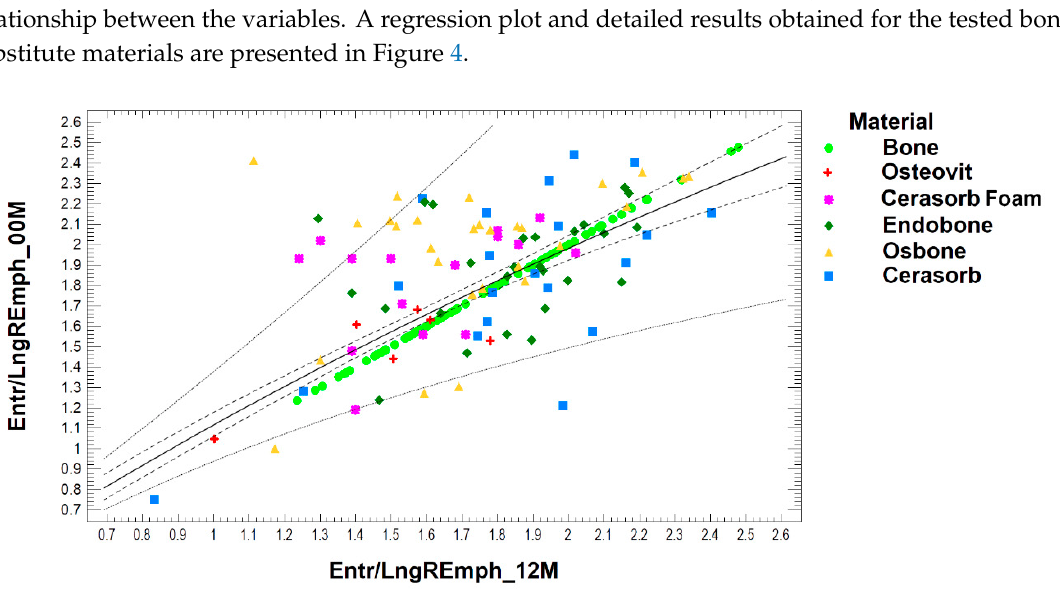
Figure 4. Dependence of the observed radiological texture at the site of biomaterial implantation created after twelve months of healing on the appearance of the radiological image of the recent biomaterial implanted. Simple regression plot calculated for all collected data. Note: solid line—regression plot; dotted line—prediction limits; dash line—confidence limit for p < 0.05.